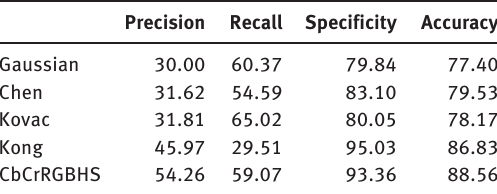
Table 8. Accuracy Results for Other Methods on the VT-AAST